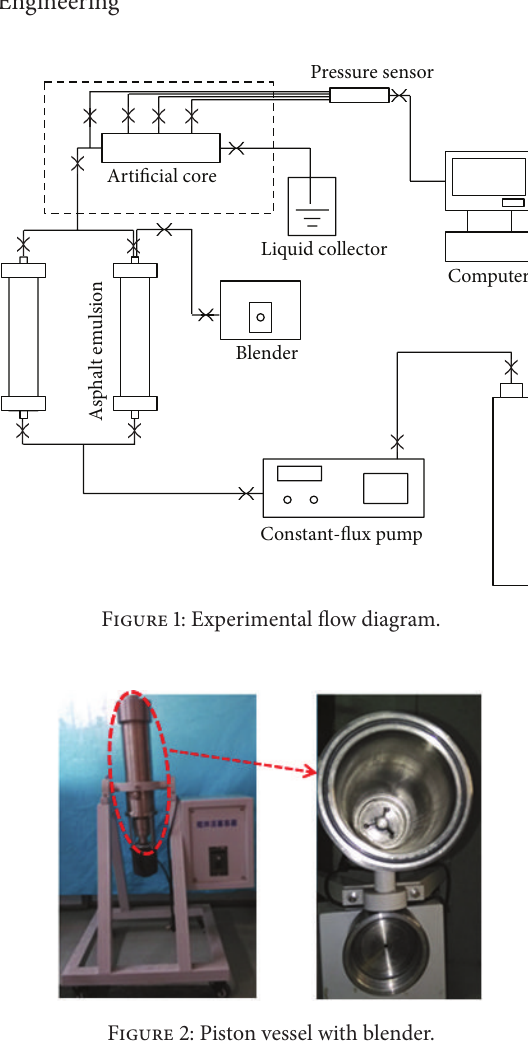
Figure 2: Piston vessel with